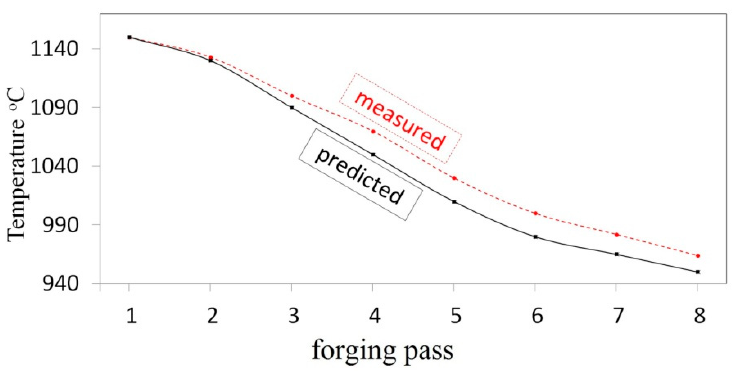
Figure 22. Comparison of the computed and the measured temperature during the cogging process of the X5CrNi18-10 steel forged in flat anvils, forging ratio 4.2.